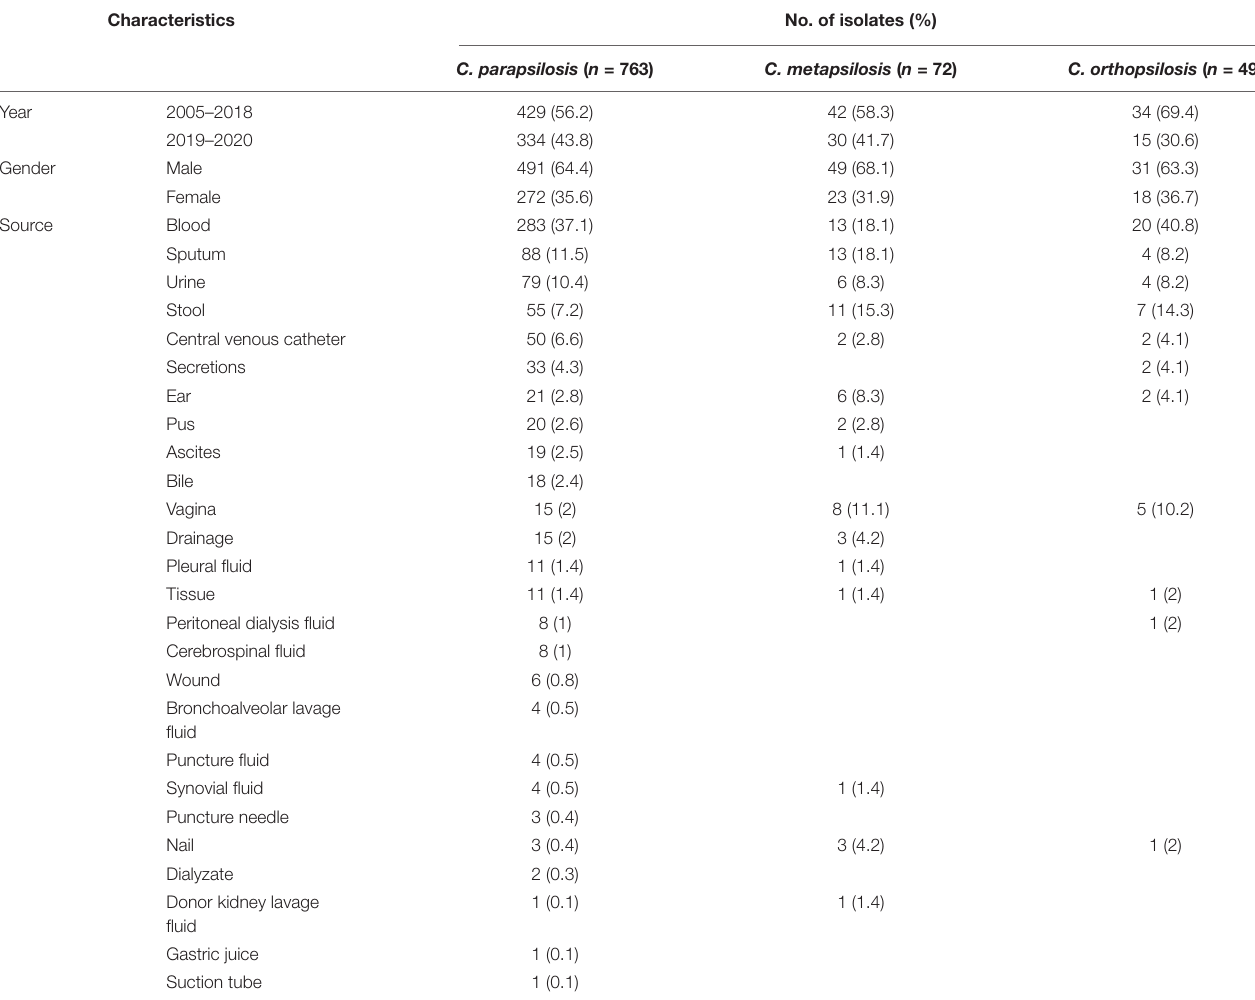
TABLE 2 | Epidemiological characteristics of the C. parapsilosis complex isolates.